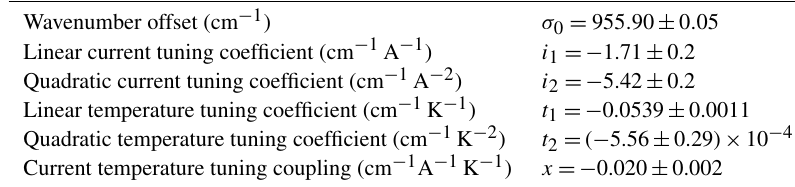
Table 2. Laser tuning coefficients corresponding to the model in Eq. (7).